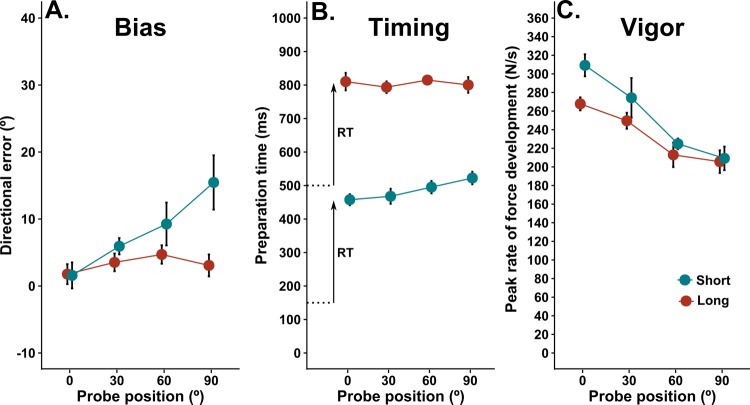
Effects of movement history in a reaction time task.Effects of movement history on aiming bias (A), the time of movement initiation after target presentation (B), and movement vigor (C) for both long and short preparation time conditions in a reaction time task. Plots show group mean values (±within subjects SE) of the median effect for each participant. Short, dashed lines in B indicate the time of the GO cue to which subjects had to react in each condition. The reaction time (RT) from the GO cue to movement initiation is indicated by the arrowhead lines.10.7554/eLife.26713.008Figure 4—source data 1.Source data for plots in panels 4a, 4b, 4c.